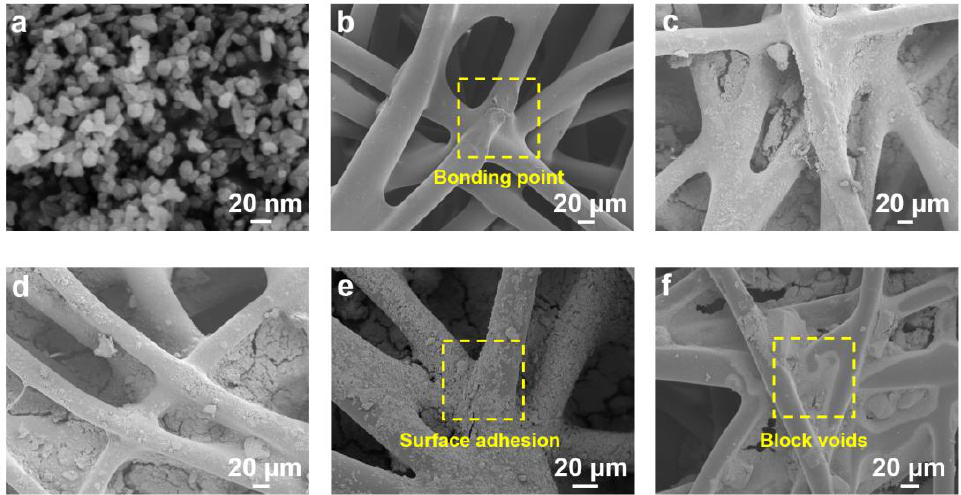
Figure 3. SEM images of ( a ) δ -MnO 2 , ( b ) bico-polyolefin nonwovens, ( c ) 10%MnO 2 @Polyolefin, ( d ) 15%MnO 2 @Polyolefin, ( e ) 20%MnO 2 @Polyolefin, and ( f ) MnO 2 @binder@Polyolefin.